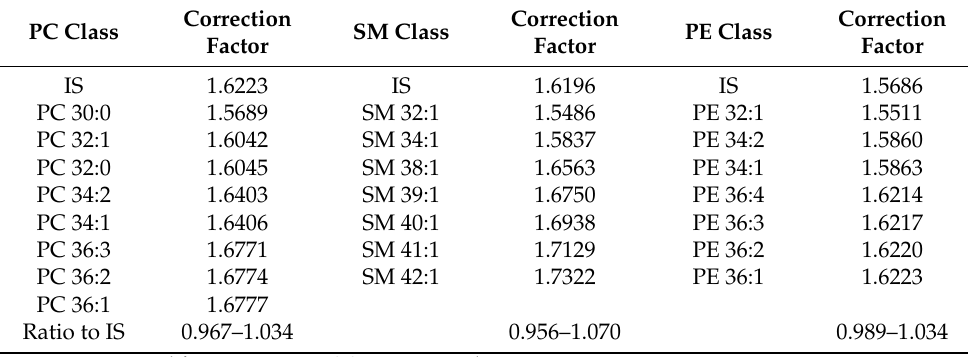
Table 3. Type 1 correction factor for the major species of PC, SM and PE of milk.